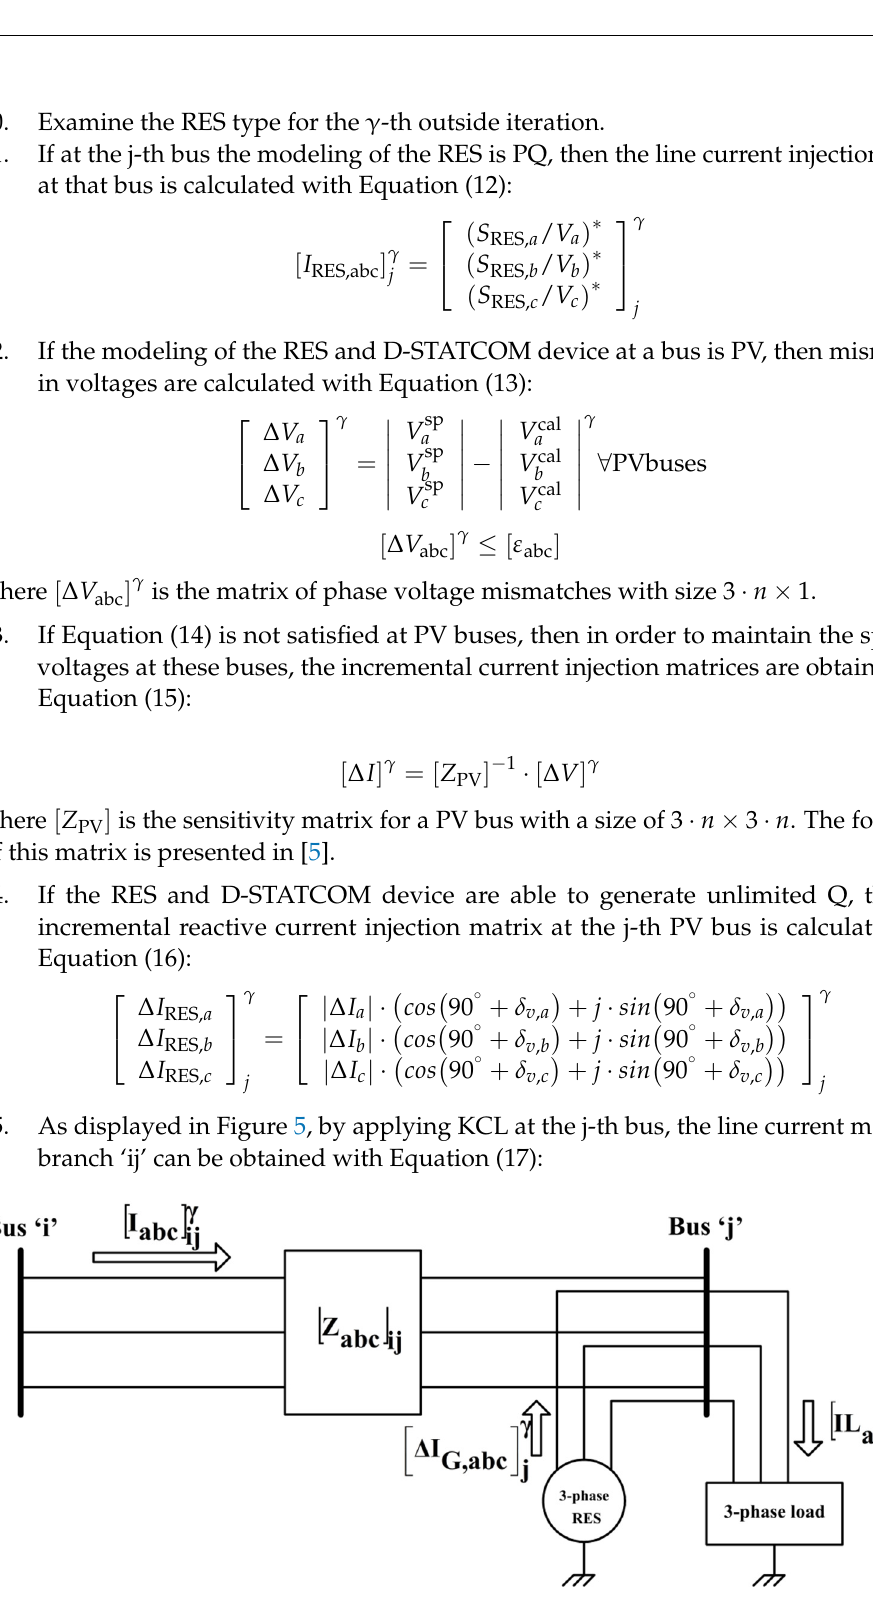
Figure 5. A simple URDN with two buses with the RES placed at the j-th